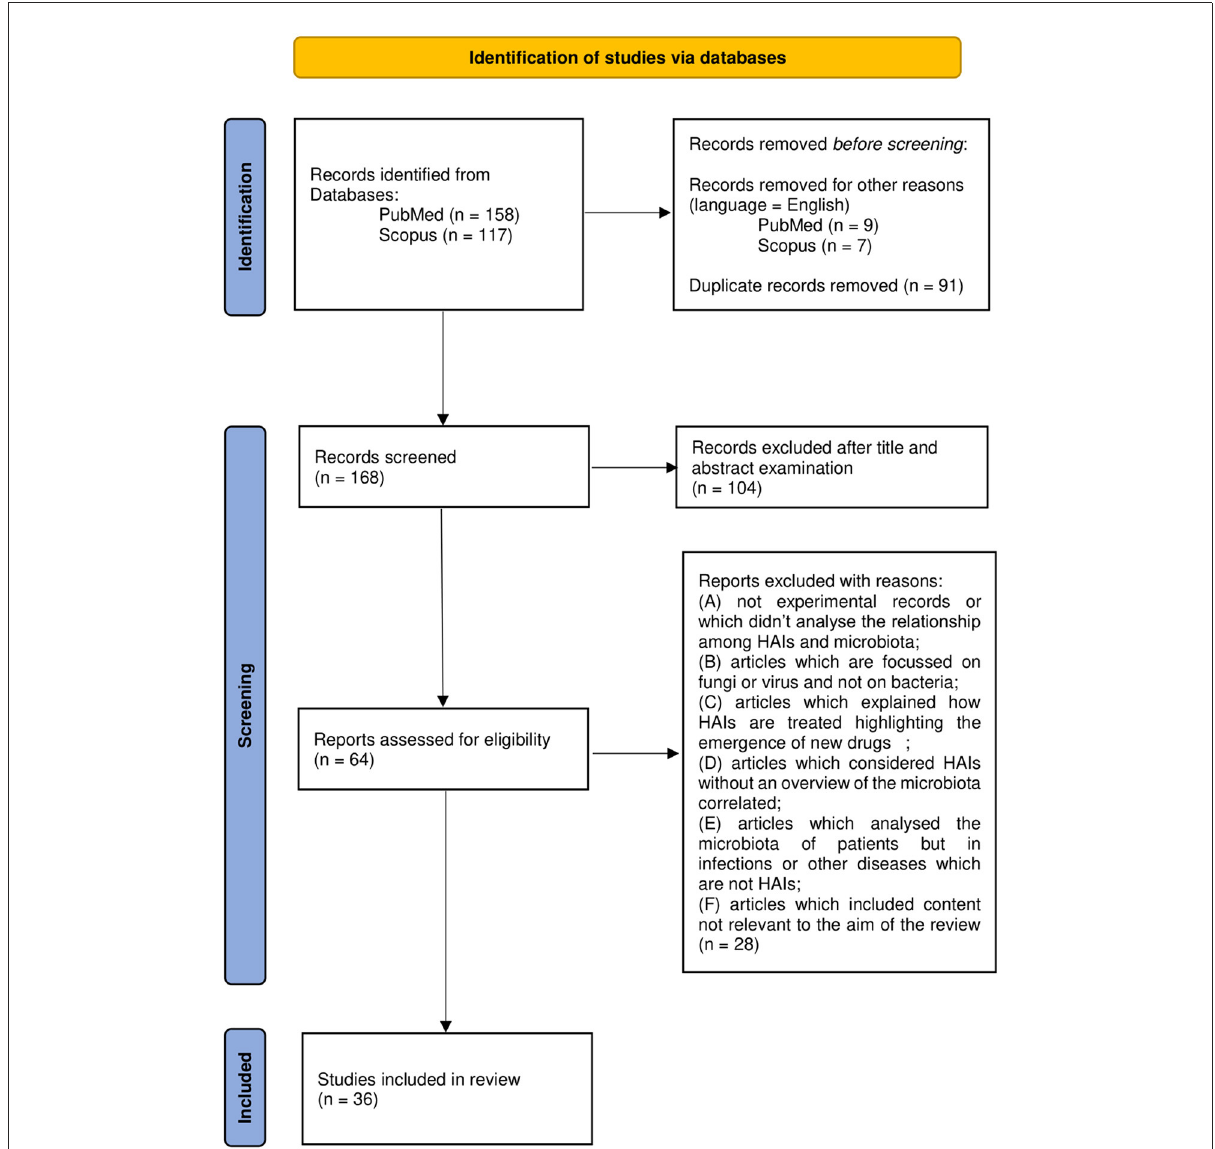
FIGURE1 Preferred Reporting Items for Systemic Reviews and Meta-Analyses (PRISMA) 2020 flow